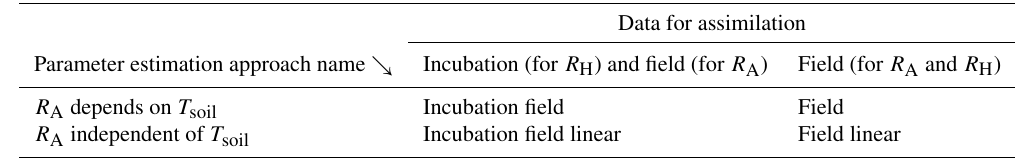
Table 3. Relationship between the different parameter estimation approaches utilized for this study.